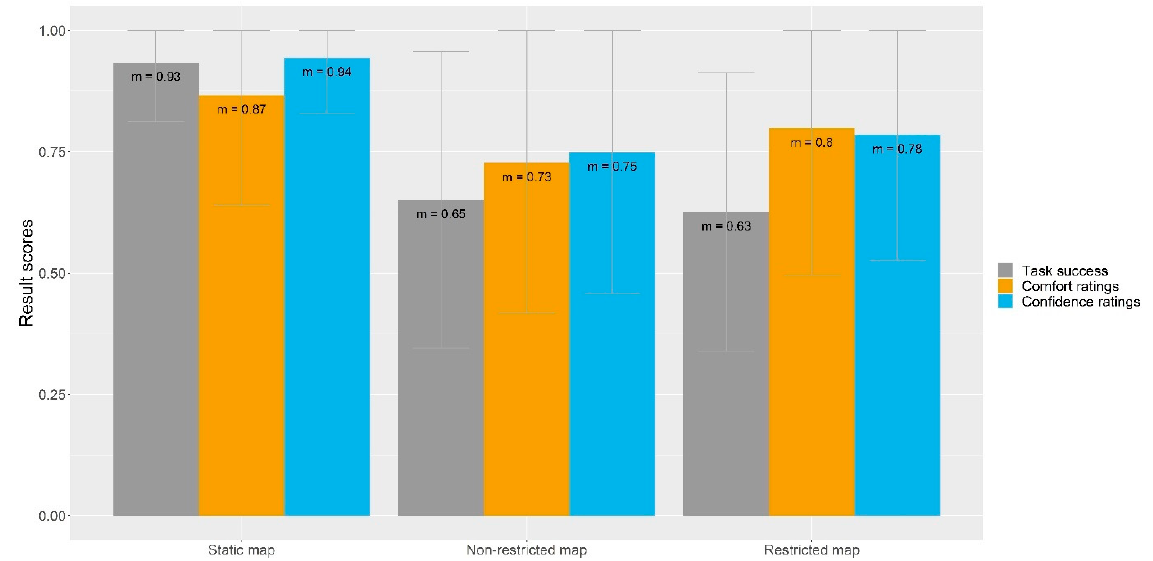
Figure 10. Task success, comfort, and confidence ratings by interactivity variant.